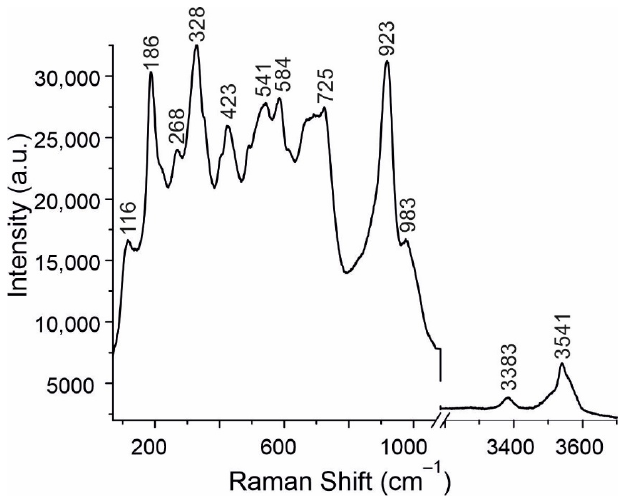
Figure 5. Raman spectrum (632.8 nm) of hingganite-(Y) from the Wanni glacier, Switzerland.